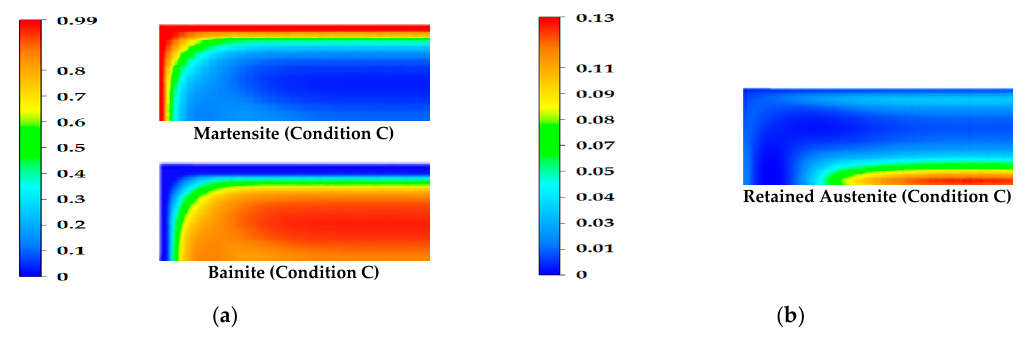
Figure 7. Distribution of phased transformed in section A-A (1/8 model) after the quenching process for simulation condition C (variable grain size and uniform %C). ( a ) Contour of martensite and bainite distributions; ( b ) Contour of retained austenite distribution.